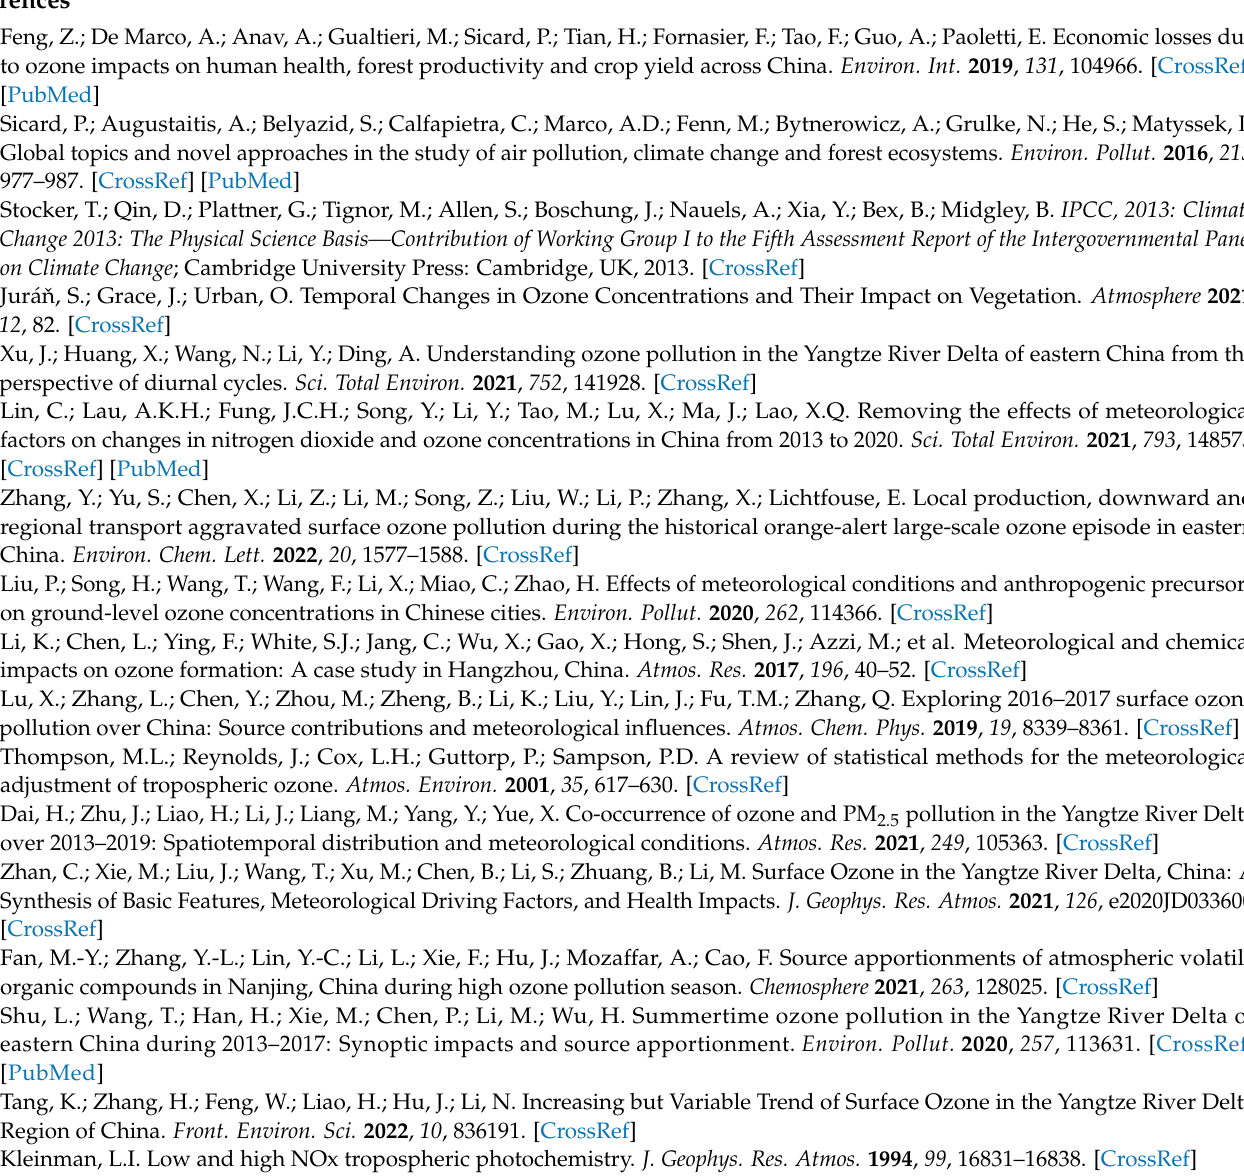
Figure A2. ( a ) Satellite observed Daily HCHO and NO 2 column densities, and ( b ) ground-level yearly NO 2 variation from dense measurements over the over the four capital cities (blue: Shanghai, black: Nanjing, red: Hangzhou, green: Hefei) in the Yangtze River Delta.